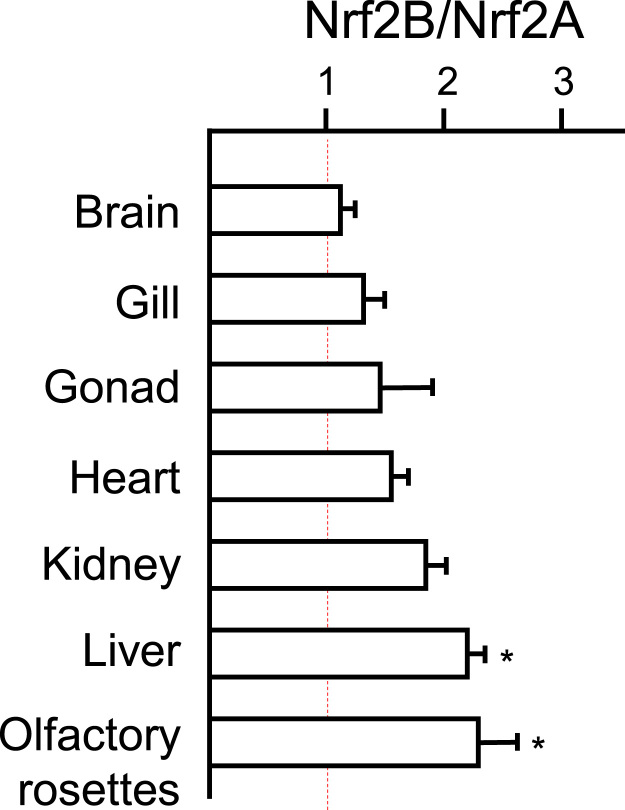
Coho Nrf2B mRNA is more abundant than Nrf2A in various tissues. Relative mRNA levels of the coho Nrf2 paralogs as determined by quantitative PCR of cDNAs, normalized to reference gene eef1a-B, and the ratio Nrf2B:Nrf2A plotted. Dashed line: ratio = 1 or equal levels of expression. *Indicates significant differences in NRF2 paralog expression at p < 0.05, One way ANOVA and Dunnett’s multiple comparisons test. n = 5.